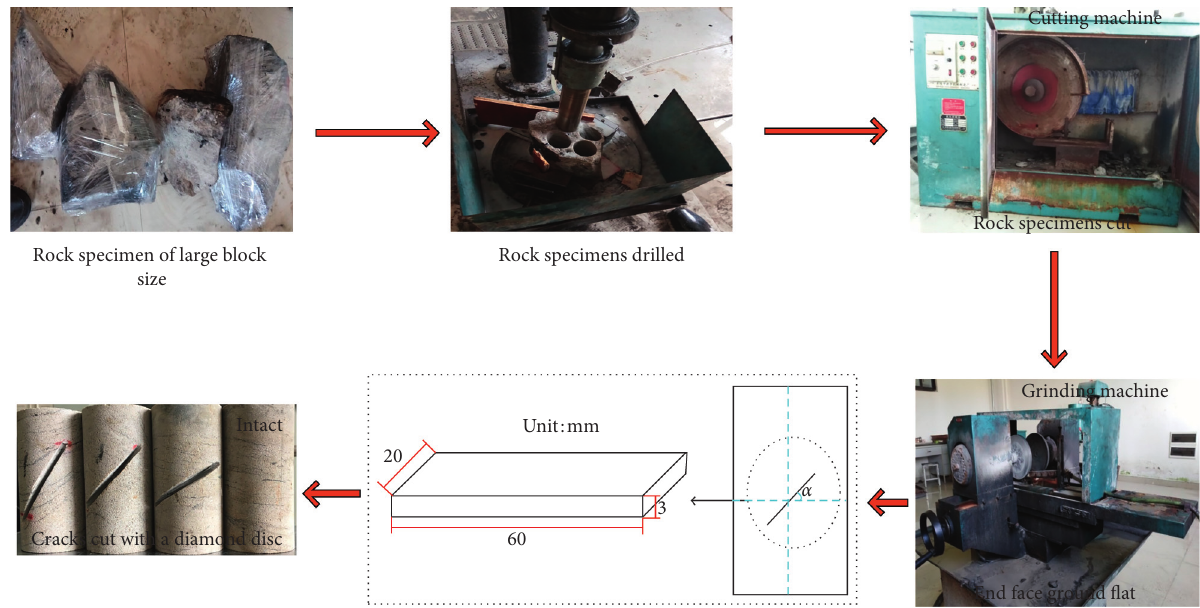
Figure 1: Rock specimen’s processing and